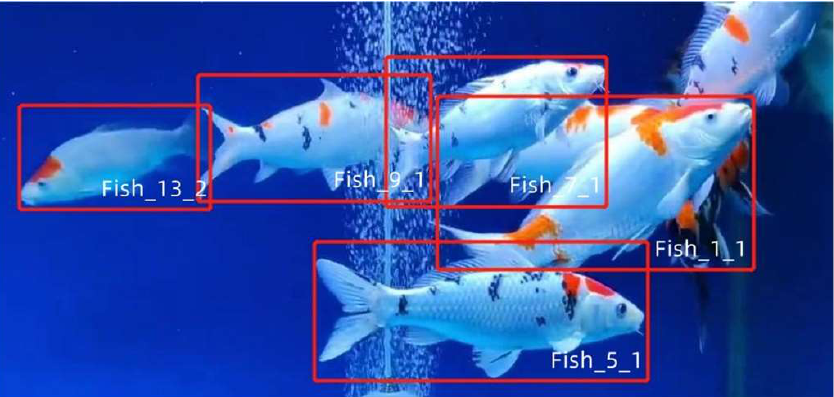
Figure 14. Visualization result.